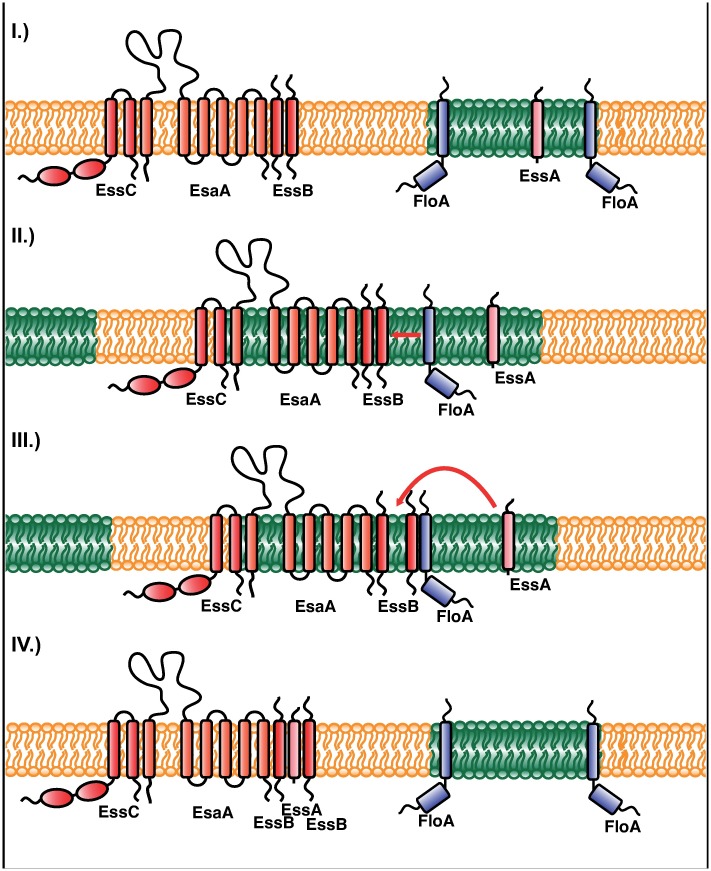
Model of FloA/FMM-mediated T7SS assembly.I.) A pre-existing, probably non-functional T7SS complex consisting of EssC, EsaA and an EssB oligomer (here represented by two EssB molecules) resides in the non-FMM membrane (yellow). FMM (green) contain EssA and FloA. II.) The EssC-EsaA-EssB pre-complex is transiently recruited to the FMM. This allows FloA to interact with EssB. III.) FloA scaffold activity promotes EssB-EssA interaction. This could help to incorporate EssA into the EssC-EsaA-EssB pre-complex. IV.) The fully assembled T7SS complex is released from FMM and is now functional.